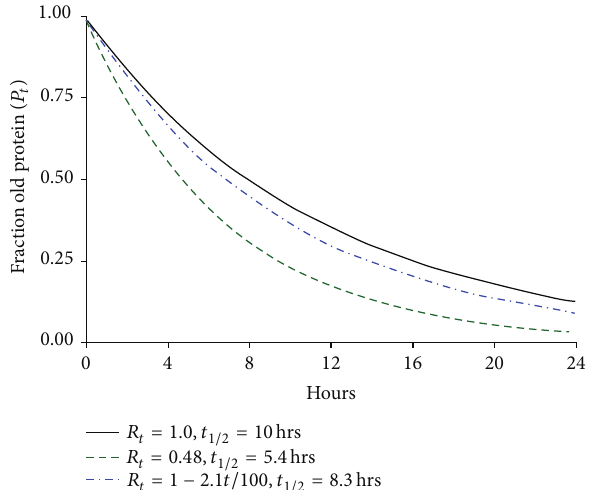
Figure 4: Plot of EGFR turnover 𝑡 1/2 data from H3255 cell line showing the effects of no amino acid recycling ( 𝑅 𝑡 = 1.0), at constant 52%( 𝑅 𝑡 =0.48),andwithalinearincreaseinrecyclingupto24hours ( 𝑅 𝑡 = 1 − 2.1 𝑡